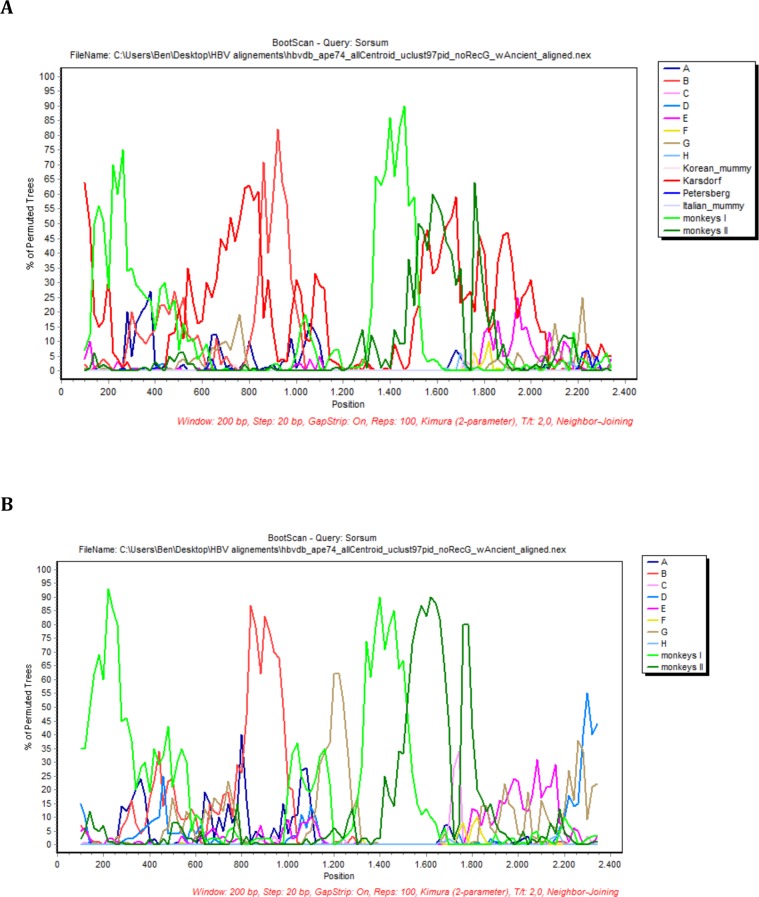
BootScan analysis of the sequence Sorsum.In each case, sequence fragments of 200 bases incrementing by 20 bases, 100 bootstrap replicates, were compared with sequence groups or 50% consensus sequences of (a) the eight human genotypes, two primate genotypes, and four ancient genomes and (b) the eight human genotypes, two primate genotypes (color coded as described in the legend).